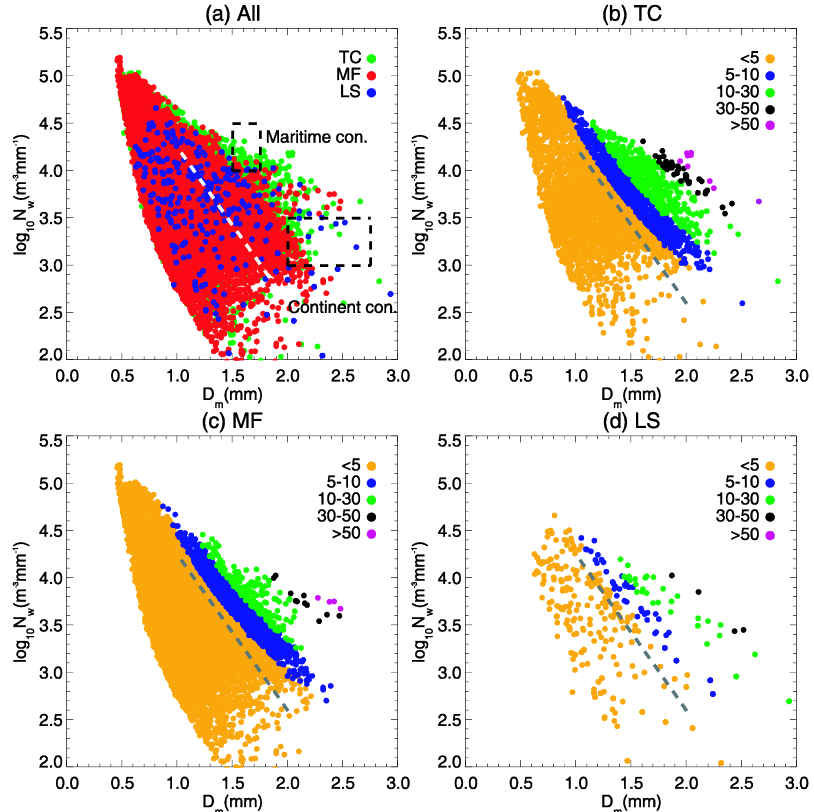
Figure 6. Scatterplot of D m versus log 10 N w for ( a ) all three rain types and for different rainfall rates in ( b ) tropical cyclones, ( c ) meiyu-baiu fronts and ( d ) local storms based on JWD data. The two gray rectangles correspond to the maritime and continental convective fields reported by Bringi et al. [34]. The dashed line is that of Bringi et al. [34], which distinguishes stratiform rain from convective rain. The values of N w ranged logarithmically from 2 to 5.2, while D m ranged from 0.3 to 2.3 mm Table 3. Mean D m and log 10 N w over di ff erent during a low rain rate of R < 5 mm/h (Figure 6b – d). Under the conditions of R < 5 mm/h, the maximal log 10 N w of the local storm was 4.7, while those of the tropical cyclone and meiyu-baiu front were 5 and 5.2, respectively. The distribution patterns of log 10 N w – D m for the tropical cyclone and meiyu-baiu front were similar in the categories of R < 5 mm/h and 5 mm/h ≤ R < 10 mm/h. The numbers of tropical cyclone rainfall events in the 10 mm/h ≤ R < 30 mm/h and R > 30 mm/h categories were greater than those of the meiyu-baiu front and local storms (Figure 6b – d). Notably, the rain rate of 5 mm/h could be used as one of the criteria to distinguish convective and stratiform